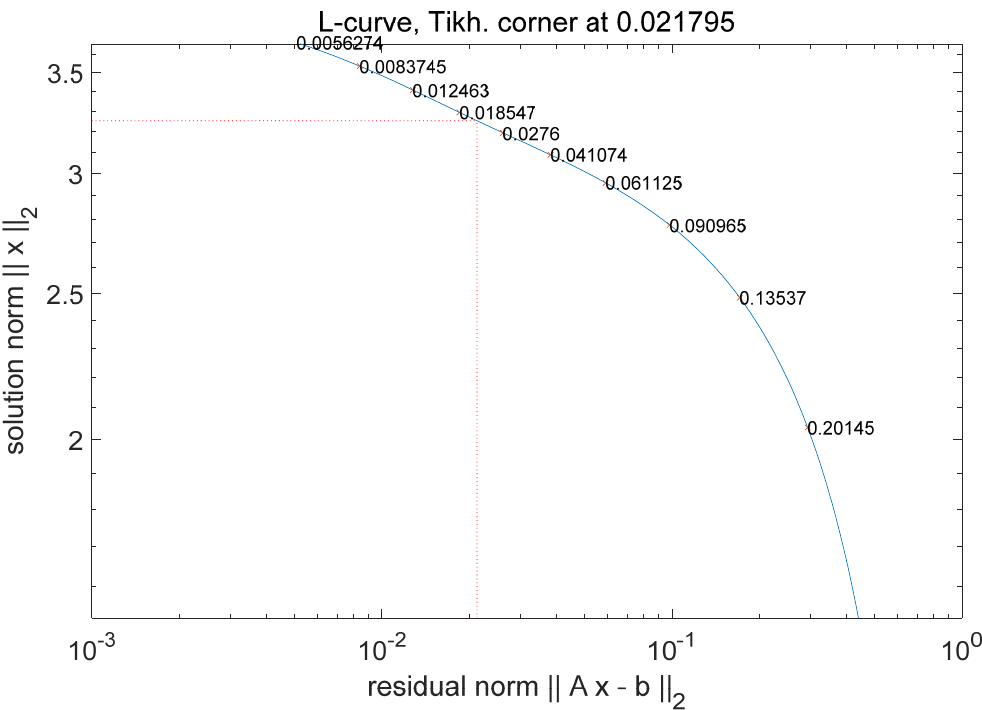
Figure 2. The L curve for determination of regularization parameters.